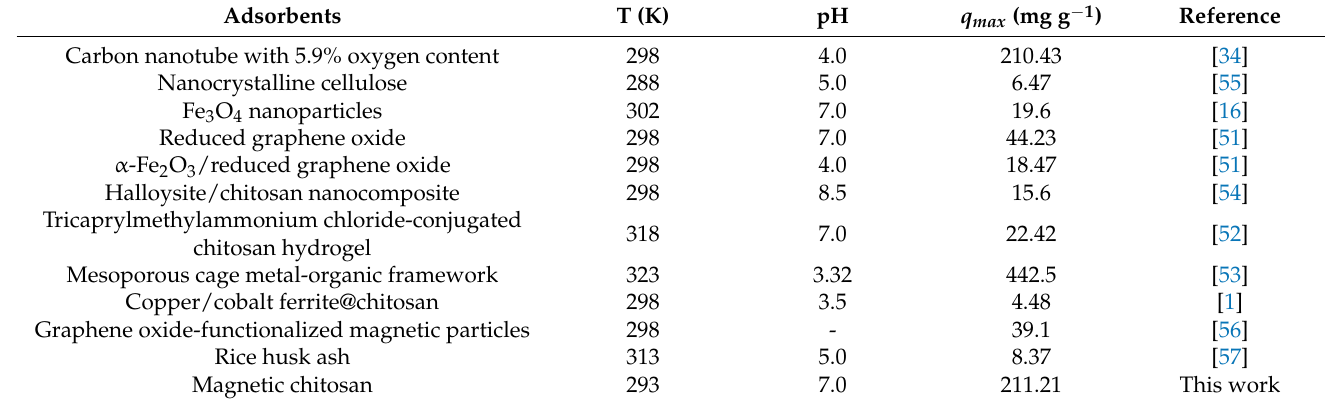
Table 4. Maximum adsorption capacities of different adsorbent materials for TC.